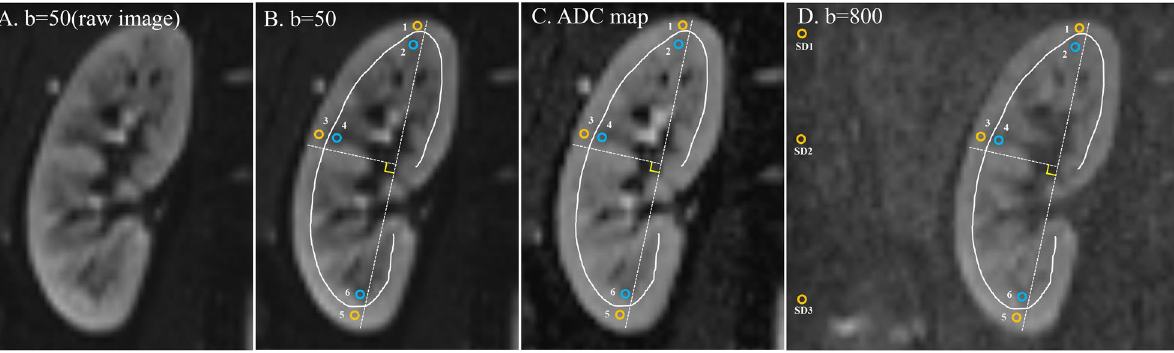
Figure 5. Schematic diagram of typical ROI placement in the renal cortex and medulla. Raw diffusion- weighted imaging (DWI) at b = 50 s/mm 2 ( A ), six representative ROIs (3 ROIs each for the renal cortex and medulla in superior, middle and inferior zones, respectively) on DWI at b = 50 s/mm 2 ( B ), corresponding ADC map ( C ) and b = 800 s/mm 2 image ( D ) for c-mCNR measurements. First, the DWI slice (using b = 50 s/ mm 2 ) with the largest renal section was chosen and a straight line was drawn along the upper and lower poles of the kidney (white dashed line). Then, a perpendicular bisector was drawn (white dashed line). Second, the medullary zone adjacent to the white dashed, which has a clear lower signal intensity was identified and the ROIs representing the superior, middle and inferior zones were drawn manually. Subsequently, three similar ROIs were drawn in renal cortex based on the representative medulla positions. These ROIs were copied to the corresponding ADC map for ADC measurement. Moreover, the background signal standard deviation (SD) for c-mCNR measured using an equally sized ROI placed at a nearby background (air) in the corresponding section, close to the site of the kidney ROI, and avoiding any prominent